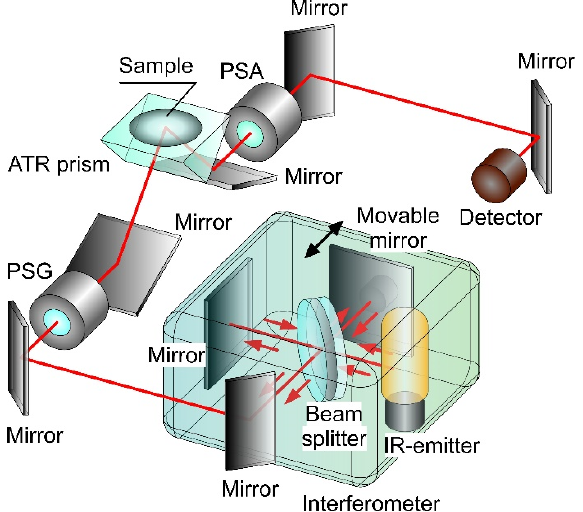
Figure 7. Scheme of ATR-FTIR spectrometer for measuring the IR spectra of MM elements of the sample placed on the ATR surface.